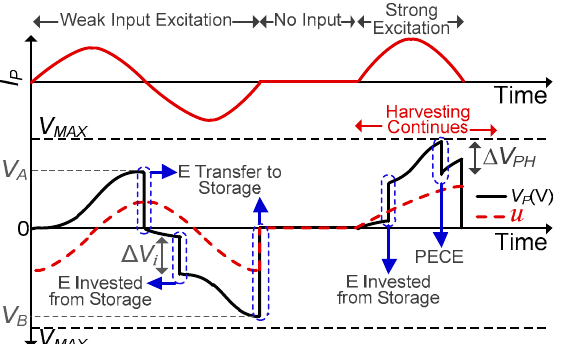
Figure 2. Conceptual waveform of proposed harvesting system with different input